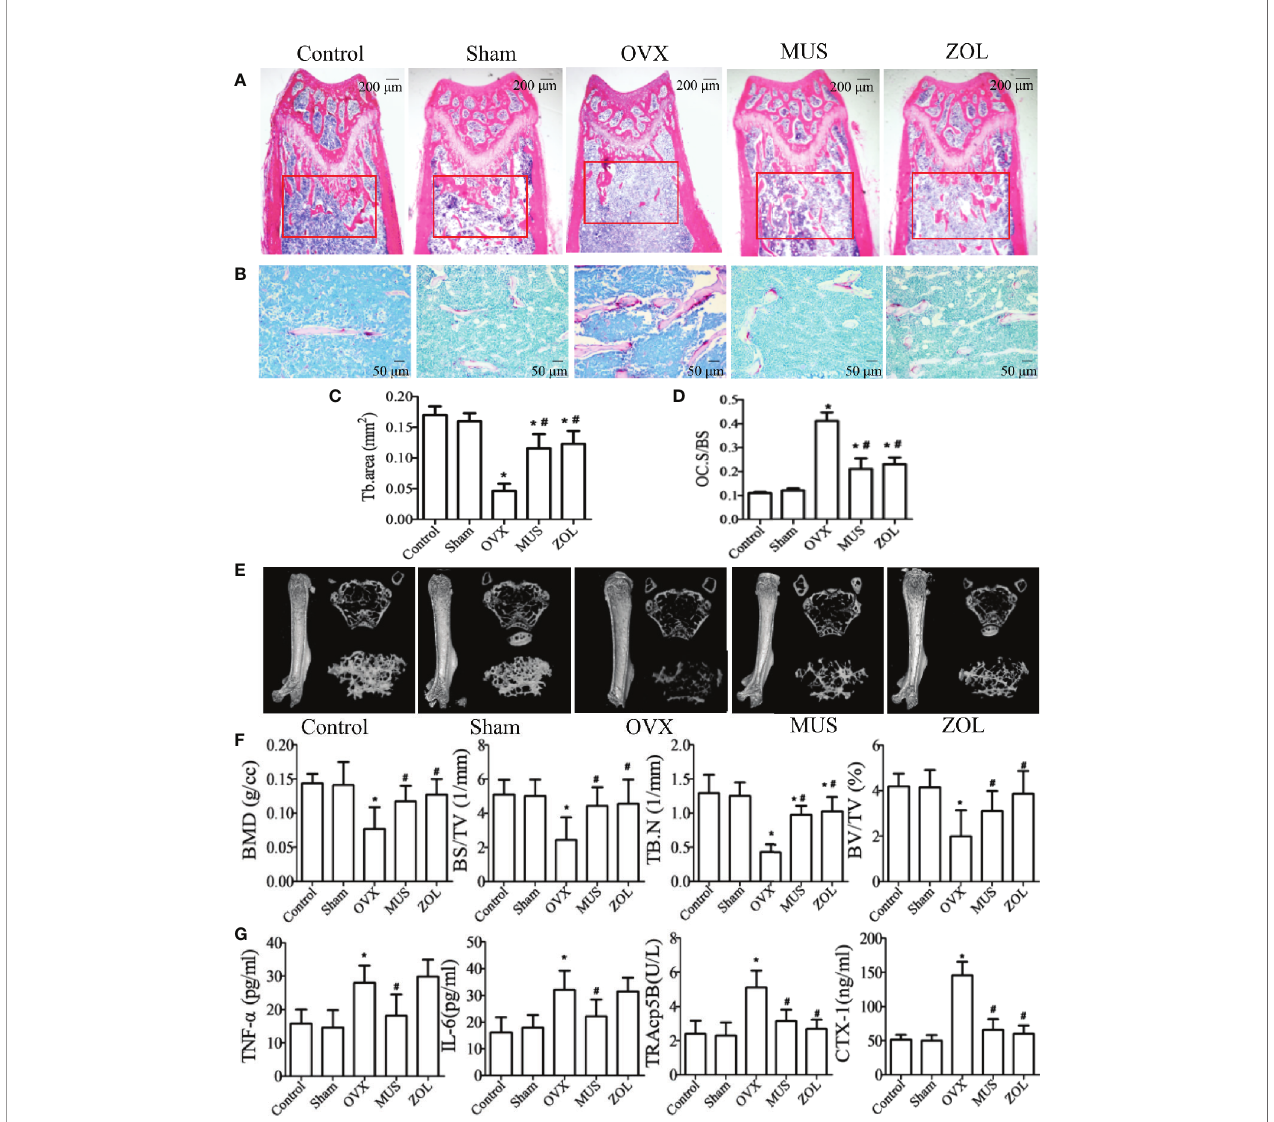
FIGURE 8 | Muscone prevents bone loss in OVX mice by suppressing osteoclastogenesis. (A, C) Mice are sacri fi ced 6 weeks after operation, and H&E staining of femoral shows that the OVX group has a signi fi cant trabecular bone loss, and the muscone group has more trabecular area. (B, D) TRAP staining shows that muscone signi fi cantly depresses osteoclasts differentiation. (E) For each femur, 100 section planes from the growth plate are scanned, and bone structure images in two-dimensional and three-dimensional version are reconstructed. (F) Bone mineral density (BMD), bone volume/total volume (BV/TV), bone surface area/total volume (BS/TV), and trabecular number (Tb.N), within the selected metaphyseal region, are showed in the charts. (G) TNF-a, IL-6, TRAcp5B, and CTX-1 are examined in serum. *P < 0.05 vs. the control group, # P < 0.05 vs. the OVX